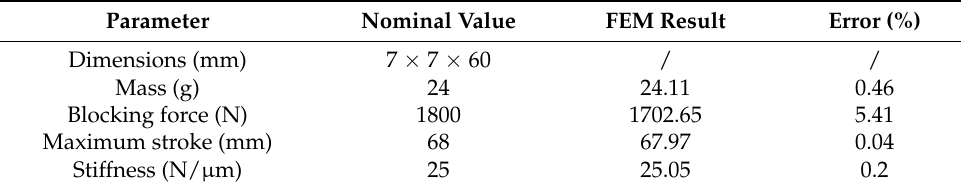
Table 2. Nominal values of the piezoelectric stack and FEM simulation